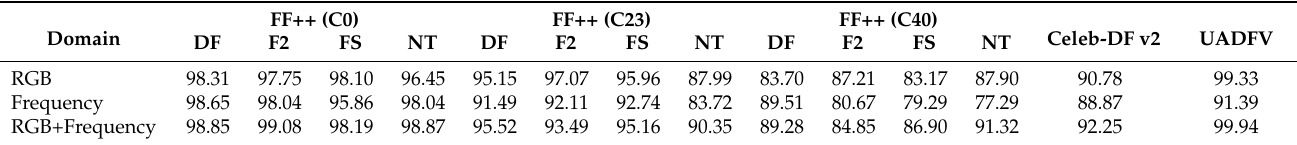
Table 6. Performance of different